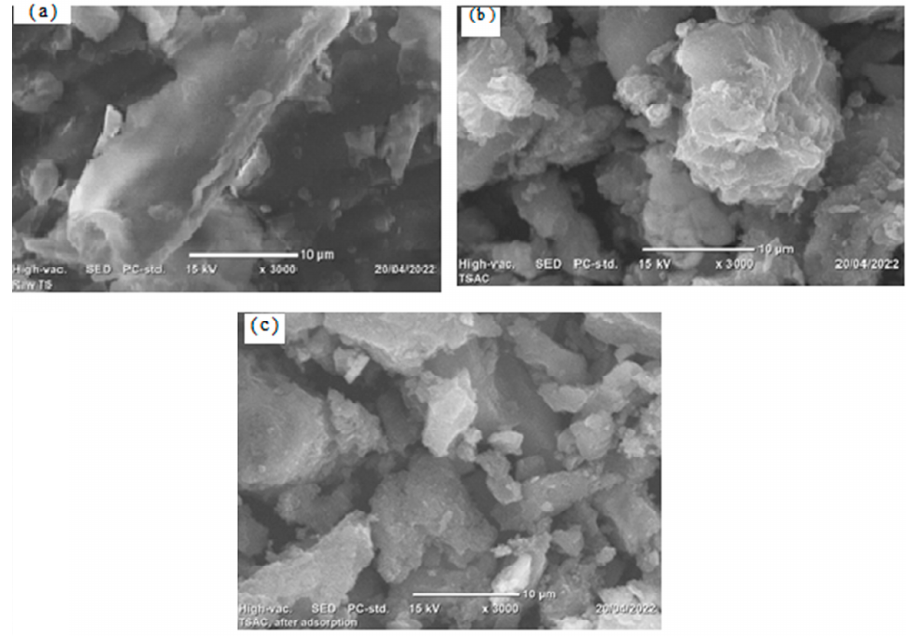
Figure 9. SEM images of Raw TS ( a ), TSAC before ( b ), and TSAC after ( c ) adsorption. Aiming to determine the pH pzc on optimal TSAC, pH drift method was executed.